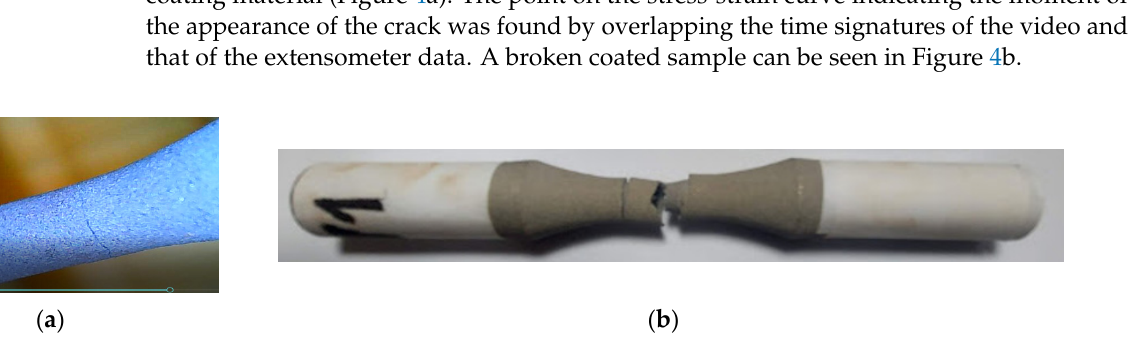
Figure 4. Sample subjected to static tensile load. ( a ) Image from the video that captures the moment of cracking of the coating material at the static tensile load; ( b ) broken sample after static tensile.